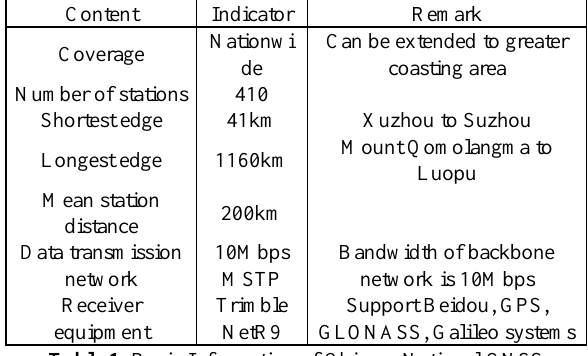
Figure 1 . The distribution of Chinese national GNSS reference stations (This figure is a schematic diagram of the topic and does not involve national territory information)